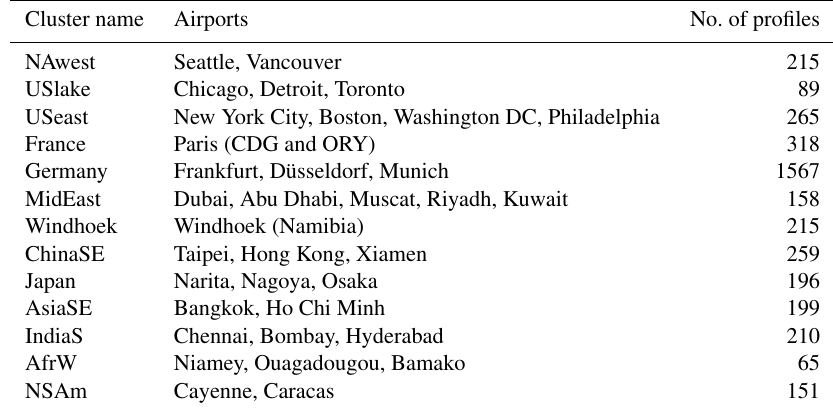
Table 5. Description of used airport clusters for vertical profiles, as well as the total number of vertical profiles. Cluster